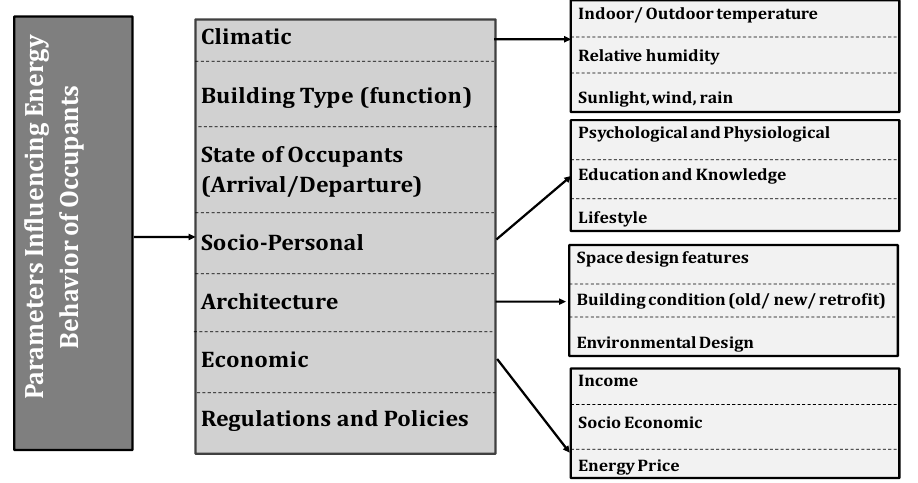
Figure 8. Factors and sub-factors influencing energy behavior of occupants. Reprinted with permis- sion from ref. [25]. Copyright 2017